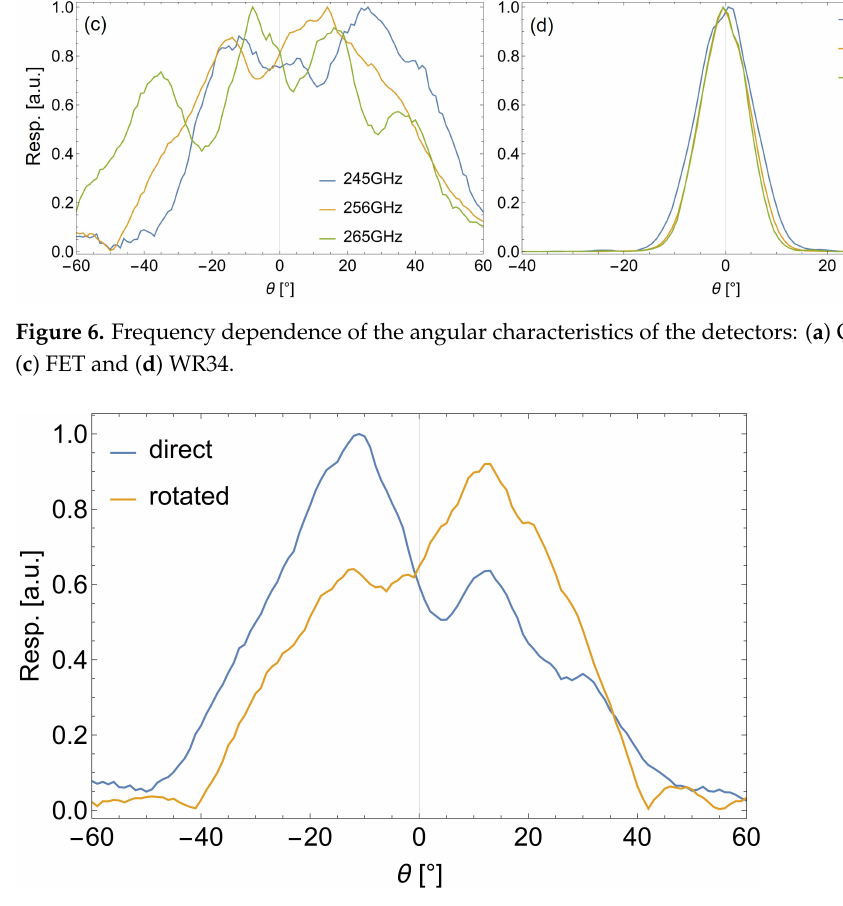
Figure 7. Comparison of the angular acceptance characteristics of the detector in nominal position (blue line) and rotated by 180 ◦ (orange